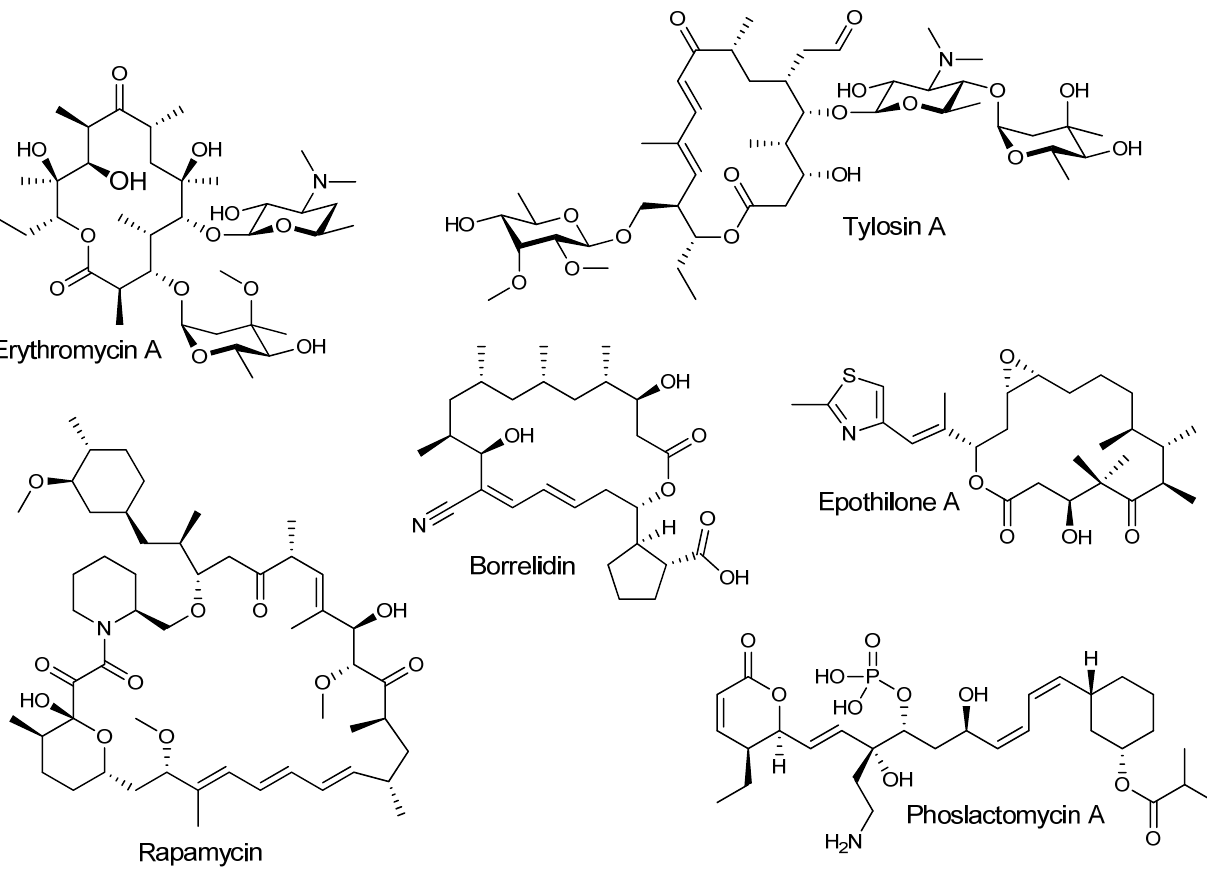
Figure 1. Bioactive complex polyketides with diverse structure and